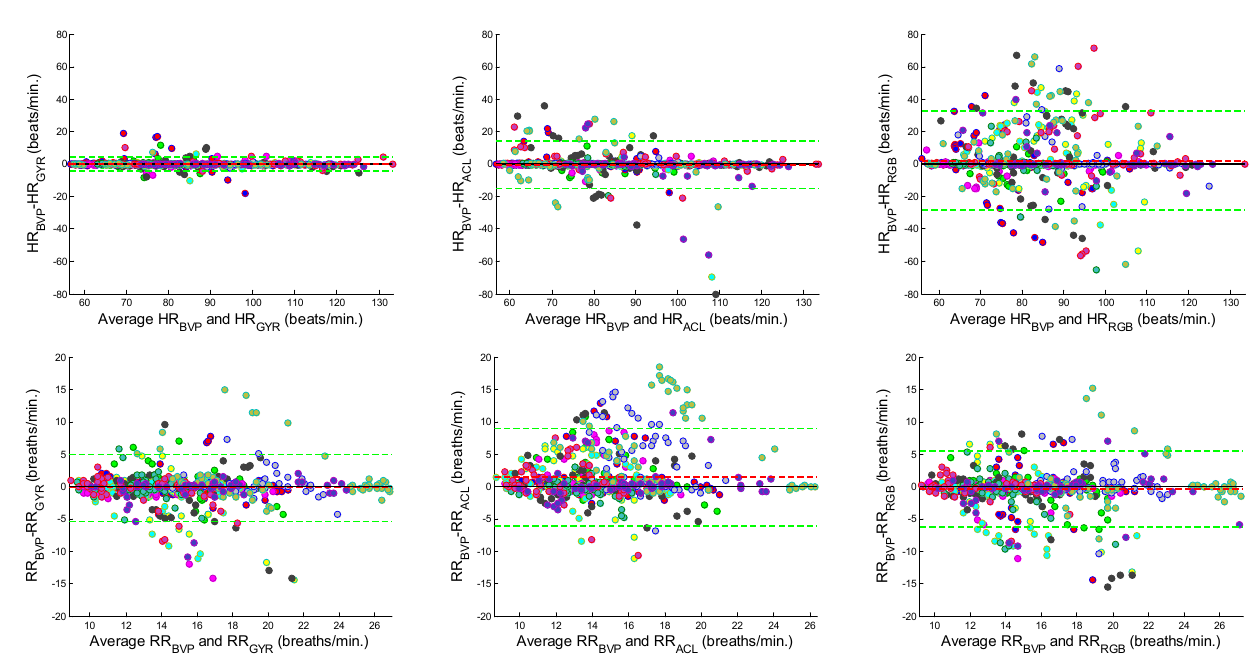
Figure 4 . Bland-Altman plots for heart (top) and respiration rates (bottom) using gyroscope (left), accelerometer (center), and camera (right). Each graph shows the agreement of 648 pairs of measurements. Data from different participants are represented with dots of different colors. Mean error is depicted with slashed red and 95% limits are depicted with slashed green lines. (HR: Heart Rate, RR: Respiration Rate, GYR: Gyroscope, ACL: Accelerometer, RGB: Camera) Table 3. Mean Absolute Error of Heart Rate Table 1. Heart Rate Estimation